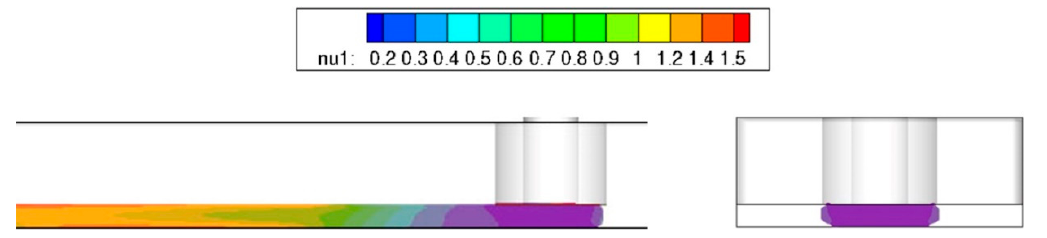
Figure 7. Kinematic viscosity distribution of an extruded strand ( U /< u > = 1, nozzle temperature = 473 K).